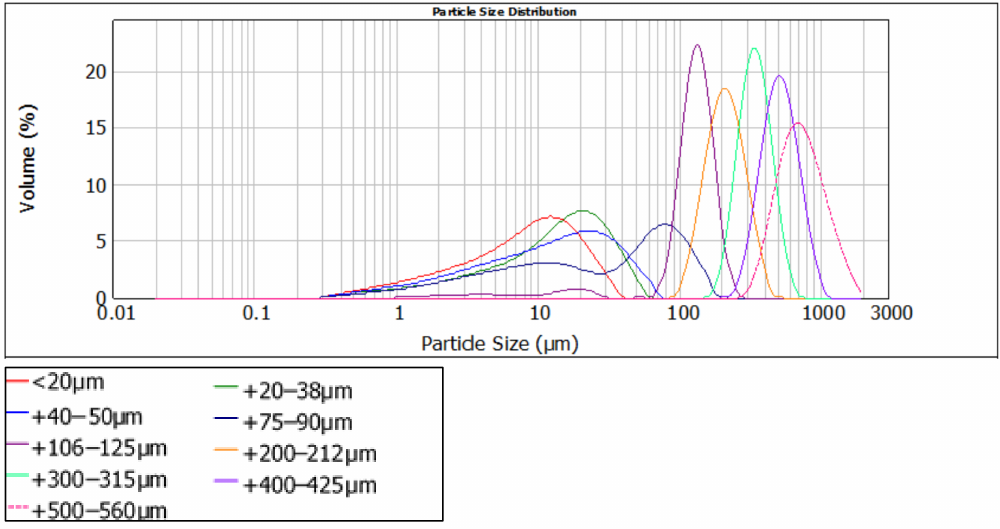
Figure 4. The size distribution of the applied nine mono-sized